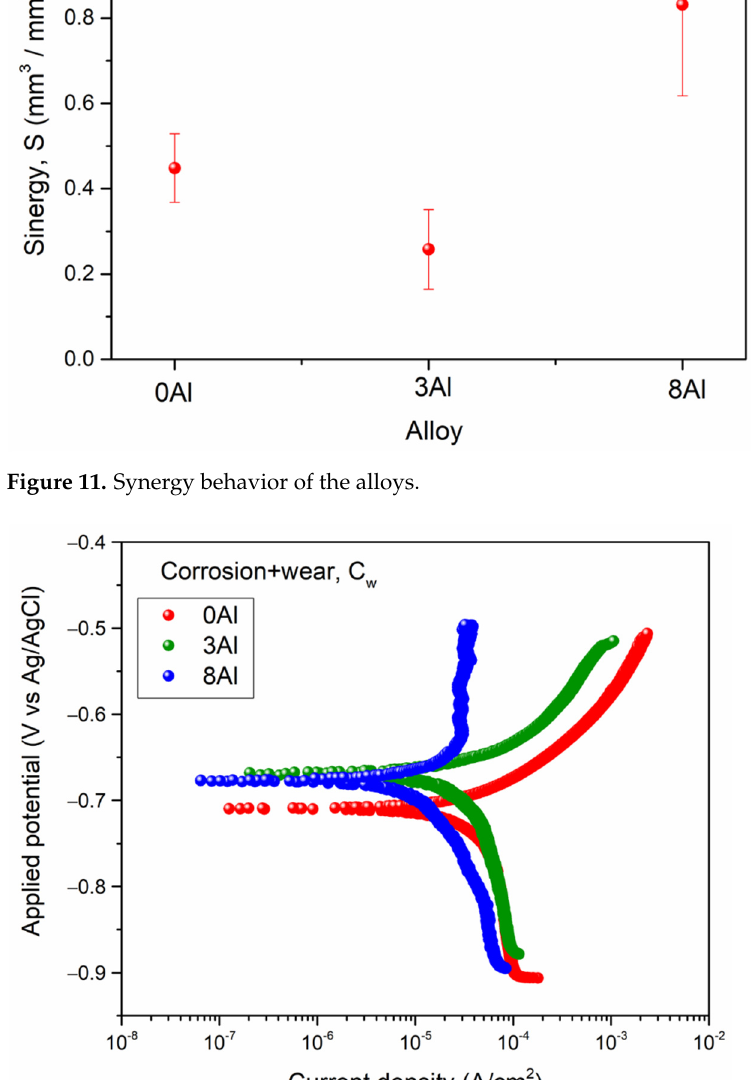
Figure 11. Synergy behavior of the alloys.